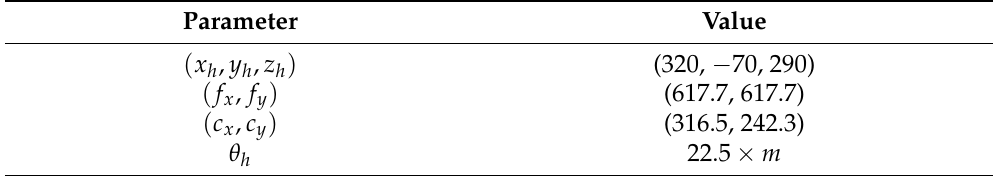
Table 3. Set values for known